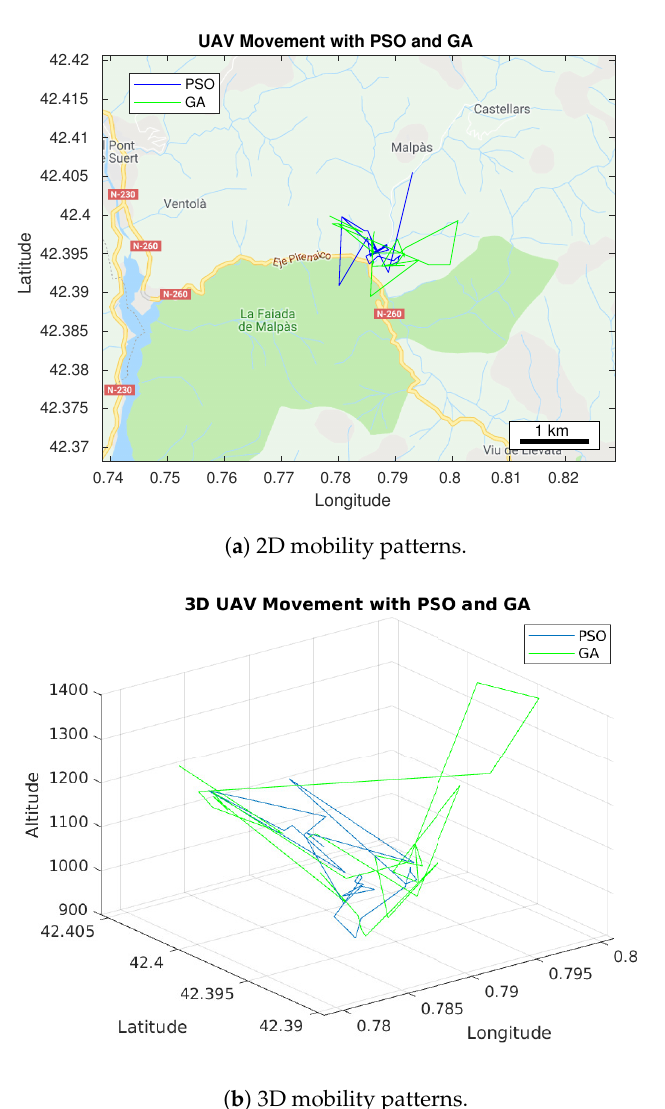
Figure 6. UAV trajectories generated by the PSO and GA algorithms.